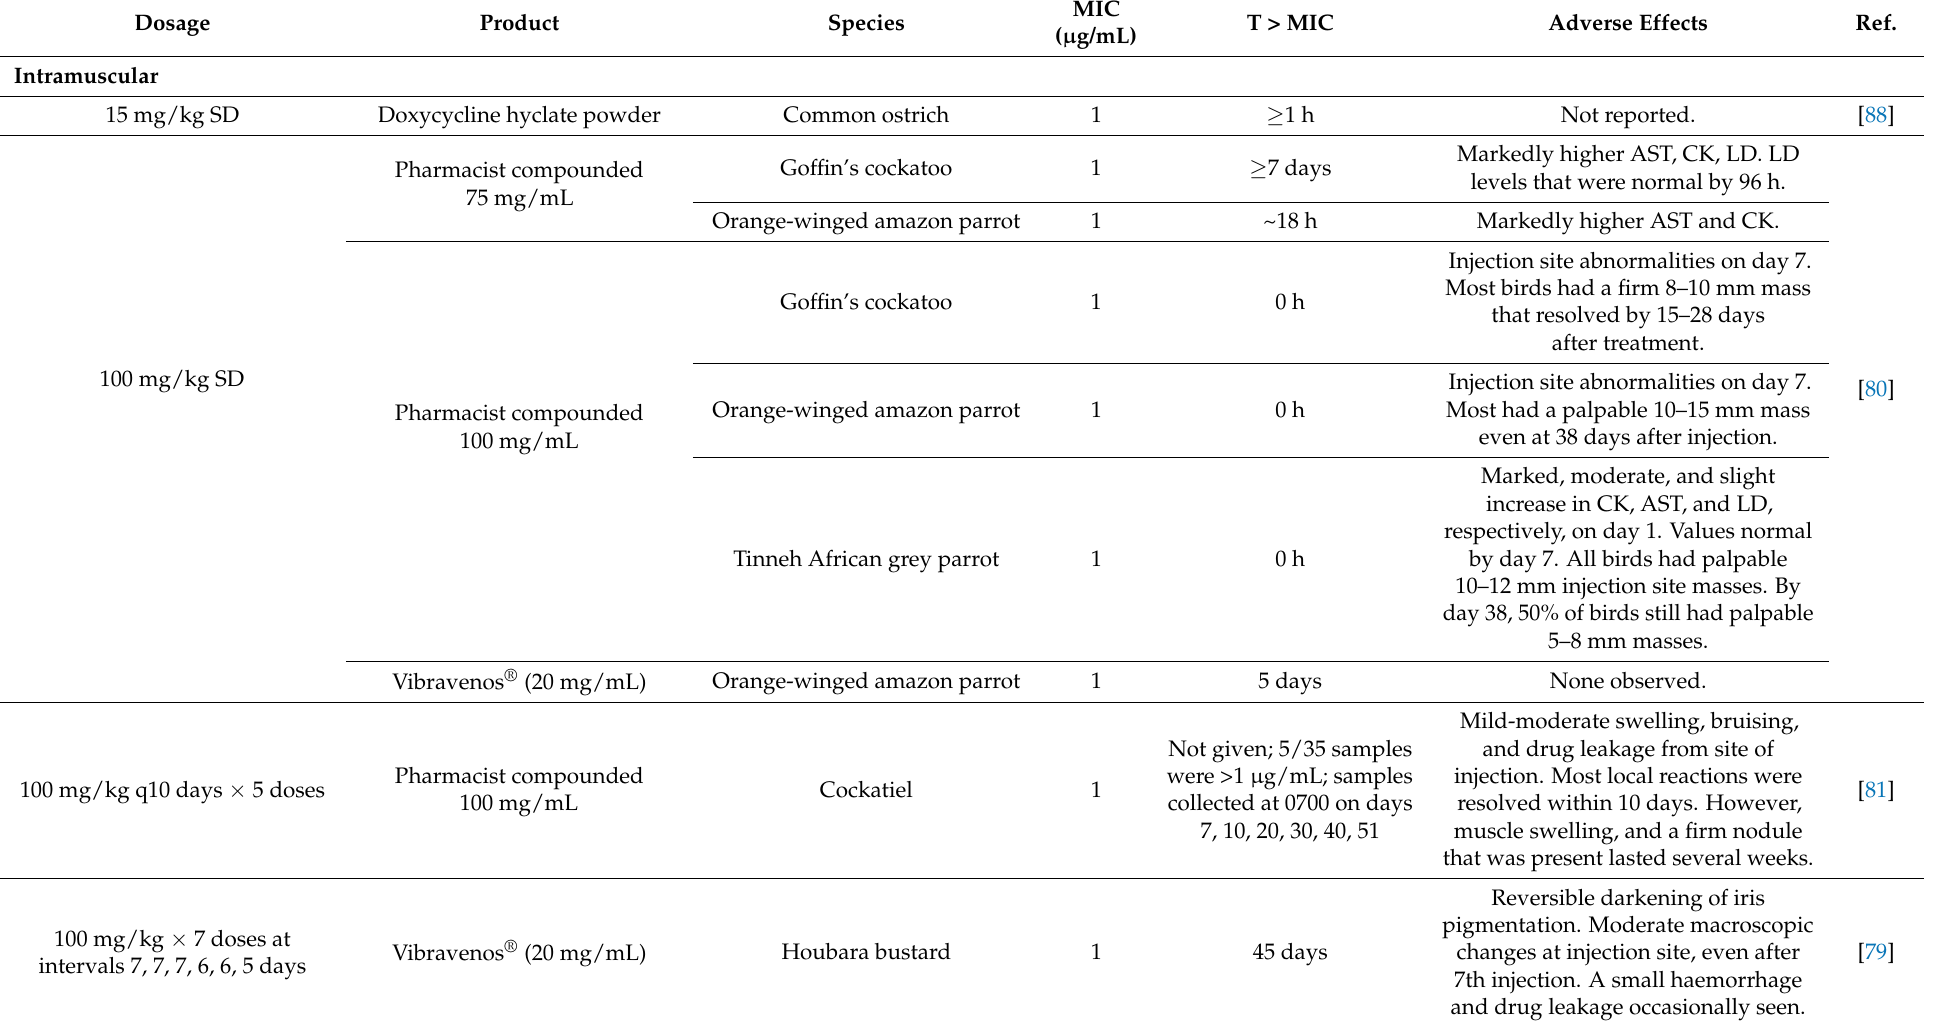
Table 12. Adverse effects and efficacy parameters of doxycycline in exotic avian